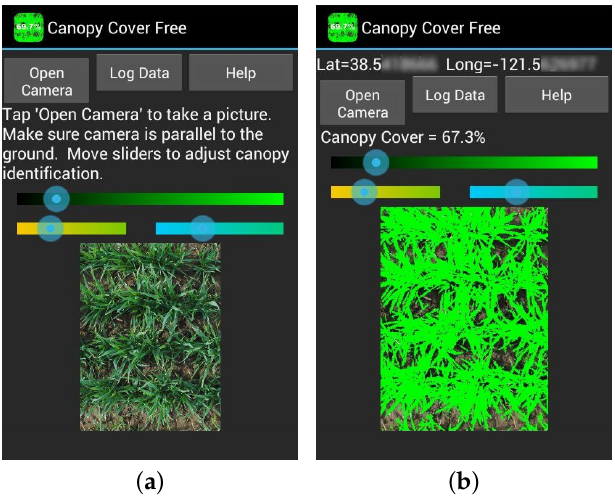
Figure 22. Canopy Cover Free: ( a ) Image capture and slider adjusting; ( b ) Image processing